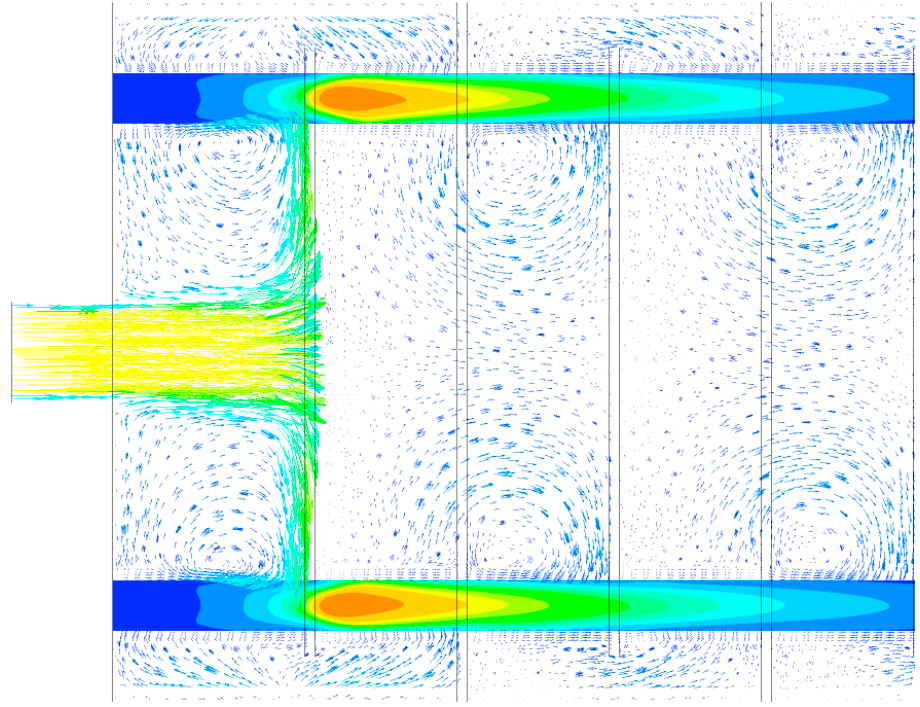
Figure 15. Effect of 20 K inlet temperature drop on the reactor. Hot-spot position and coolant velocity overlay field at t = 200 s. overlay field at t = 200